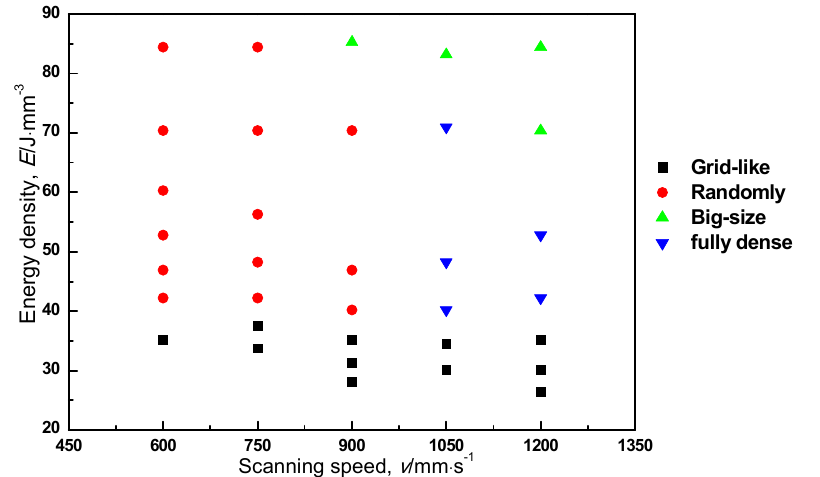
Figure 7. Processing map of the pore distribution at five different scanning speeds and corresponding energy densities.